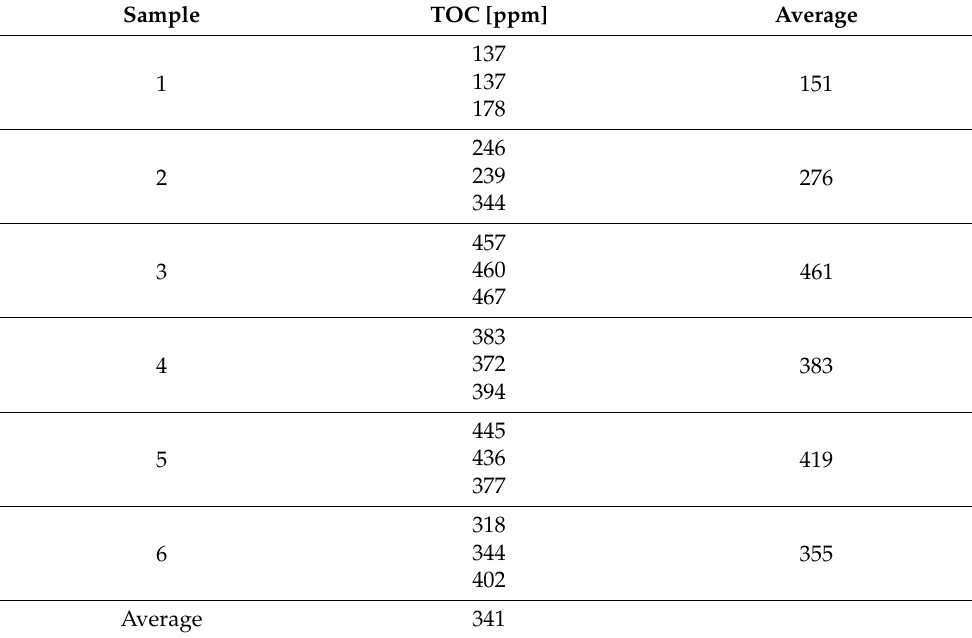
Table 1. TOC analysis results for waste samples collected on the